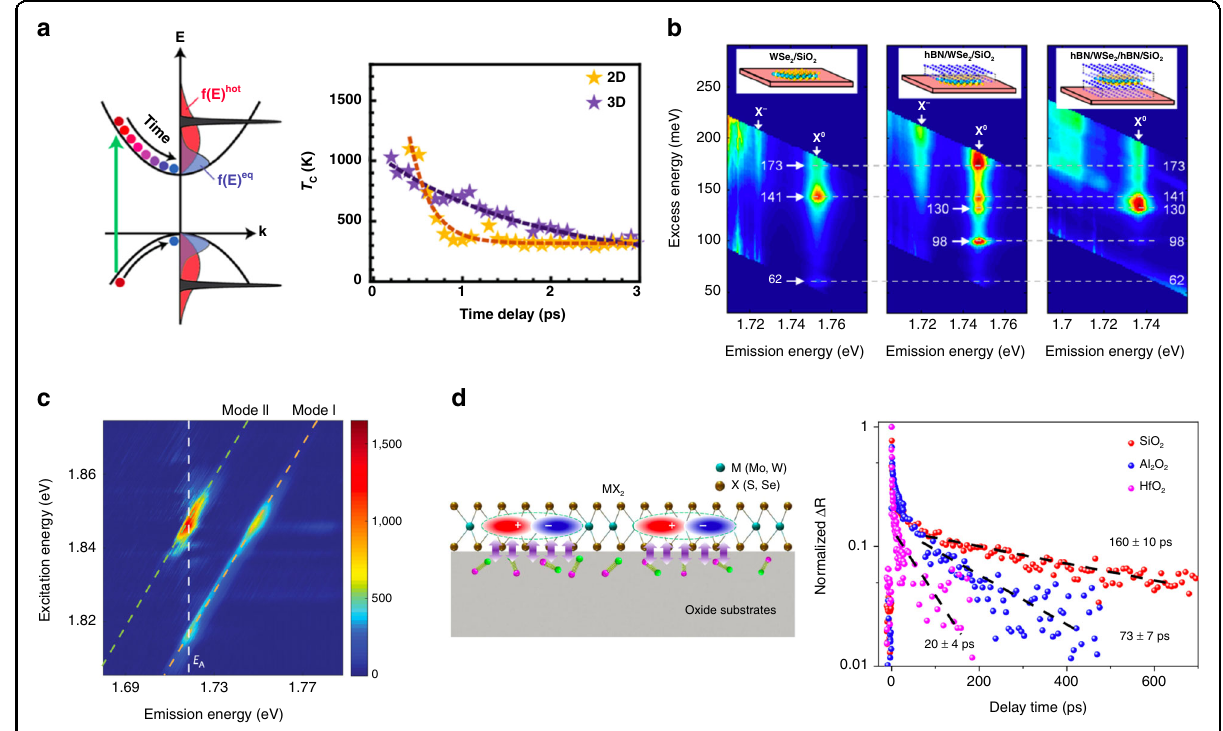
Fig. 6 Phonon-assisted photocarrier relaxation. a Photoexcited charge carrier cooling in methylammonium lead iodide (MAPI) nanoplatelets (NPls). (Left) Scheme of the thermalization and relaxation of photoexcited electrons and holes in the one-particle picture. (Right) Transients of the calculated carrier temperature T c (cooling curves) for quasi-3D and 2D samples. b (From left to right) PLE intensity plots of WSe 2 /SiO 2 , h BN/WSe 2 /SiO 2 , and h BN/WSe 2 / h BN/SiO 2 samples at 5 K. c Raman excitation spectrum of the WSe 2 / h BN heterostructure at 77 K. d Ultrafast photocarrier dynamics of monolayer MoSe 2 on different oxide substrates. (Left) Illustration of interfacial electron – phonon ( e – ph ) coupling. (Right) Photocarrier dynamics of monolayer MoSe 2 on different substrates. Figure reproduced with permission from a ref. 76 , © 2018 American Chemical Society; b ref. 79 , © 2017 American Chemical Society; c ref. 80 , © 2016, Springer Nature; d ref. 47 , © 2019 Springer